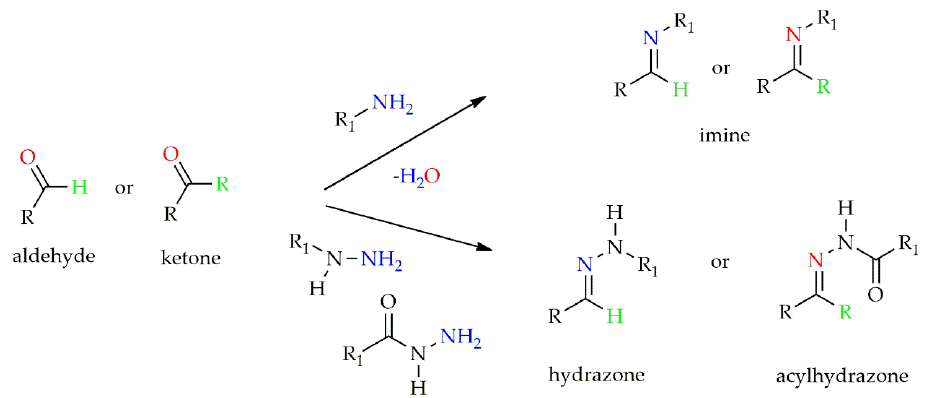
Figure 2. Synthesis of hydroxybutyl